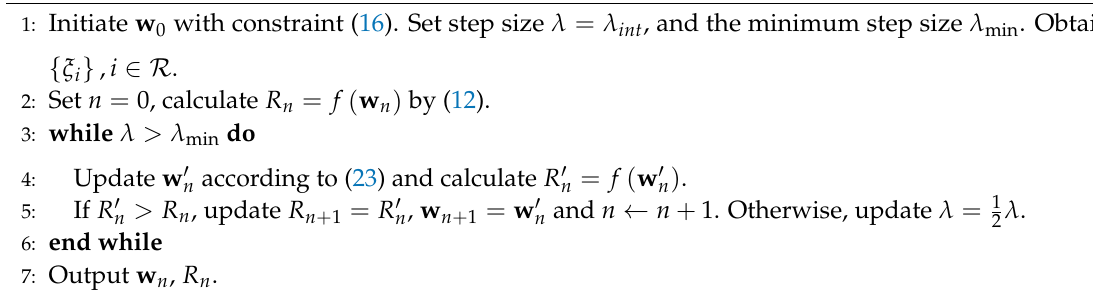
Algorithm 2 Optimal beamforming policy